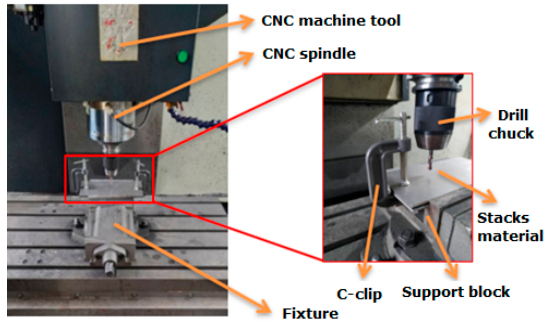
Figure 2. The manufacturing device.